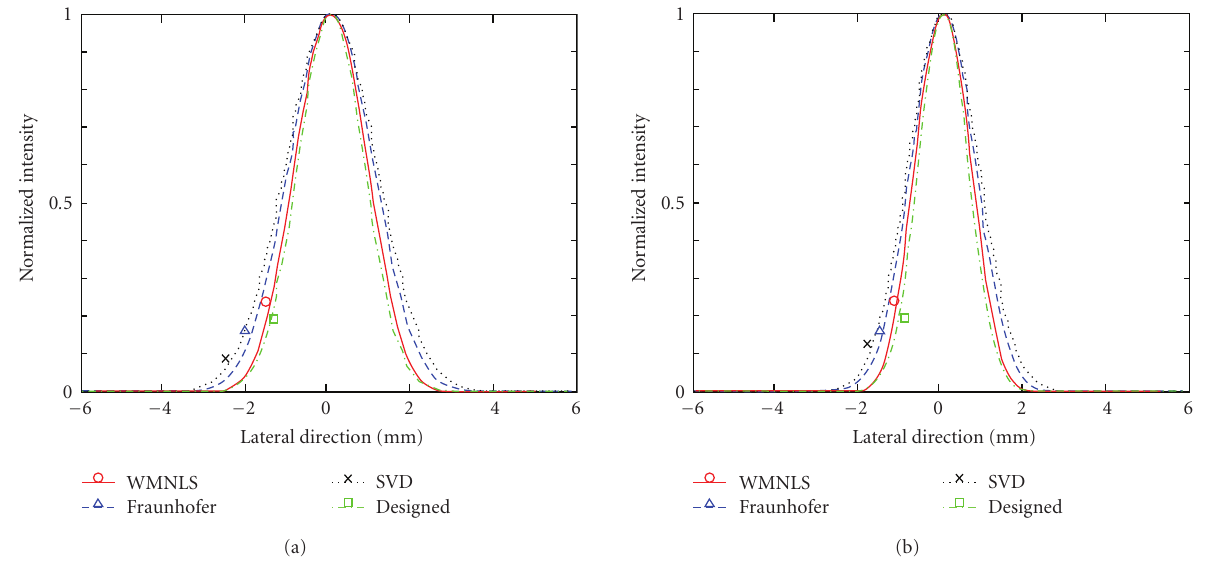
Figure 3: Lateral intensity profiles of a designed PSF (dash-dot line with square) and PSFs obtained using apodization functions obtained with a regularized WMNLS estimation (solid line with circle), a Fraunhofer approximation (dashed line with triangle) and a SVD (dotted line with cross) for (a) σ y = 0.8 and (b) 0.6mm.